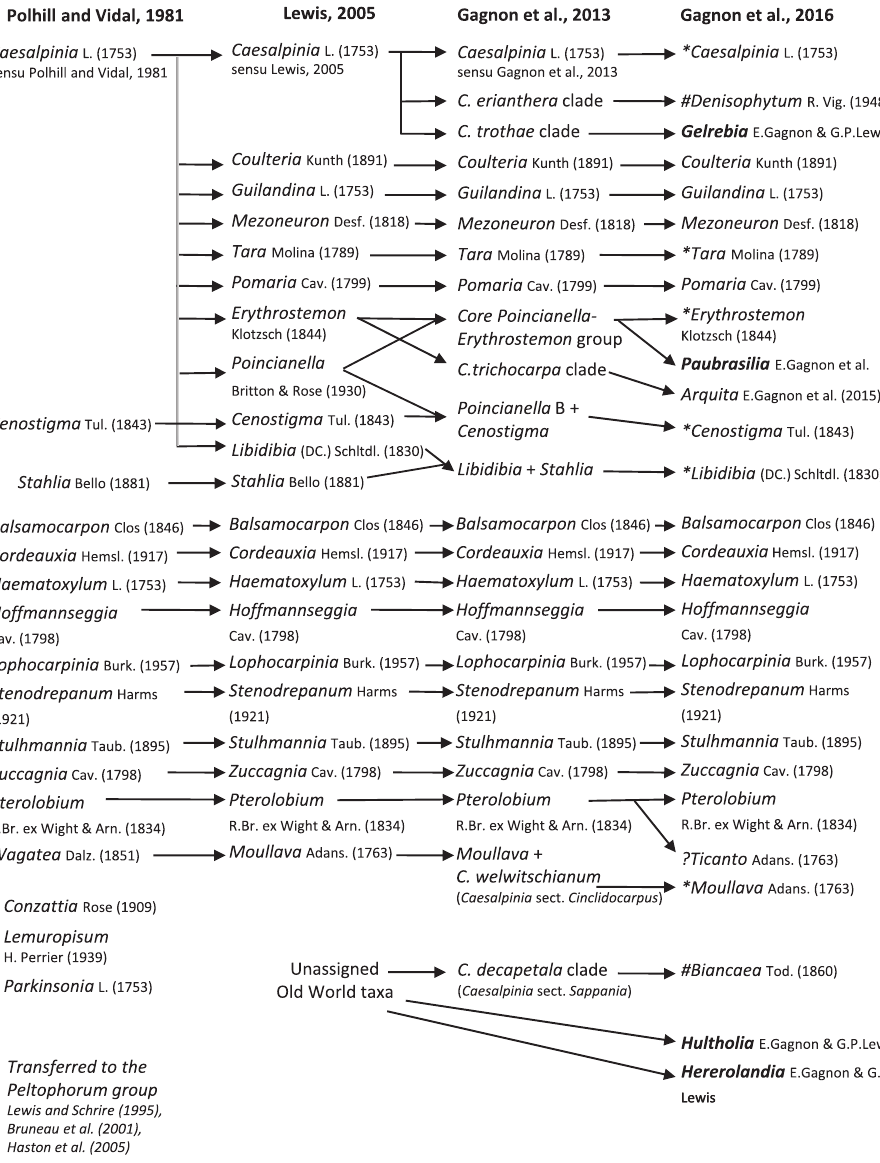
Figure 1. Comparison of generic classifications for the Caesalpinia group proposed by Polhill and Vidal (1981), Lewis (2005), Gagnon et al. (2013), and this study; names in bold represent new genera described here; prefix * indicates that the description of the genus is emended; prefix # indicates that the genus is being re-instated; prefix ? indicates that the status of the genus is